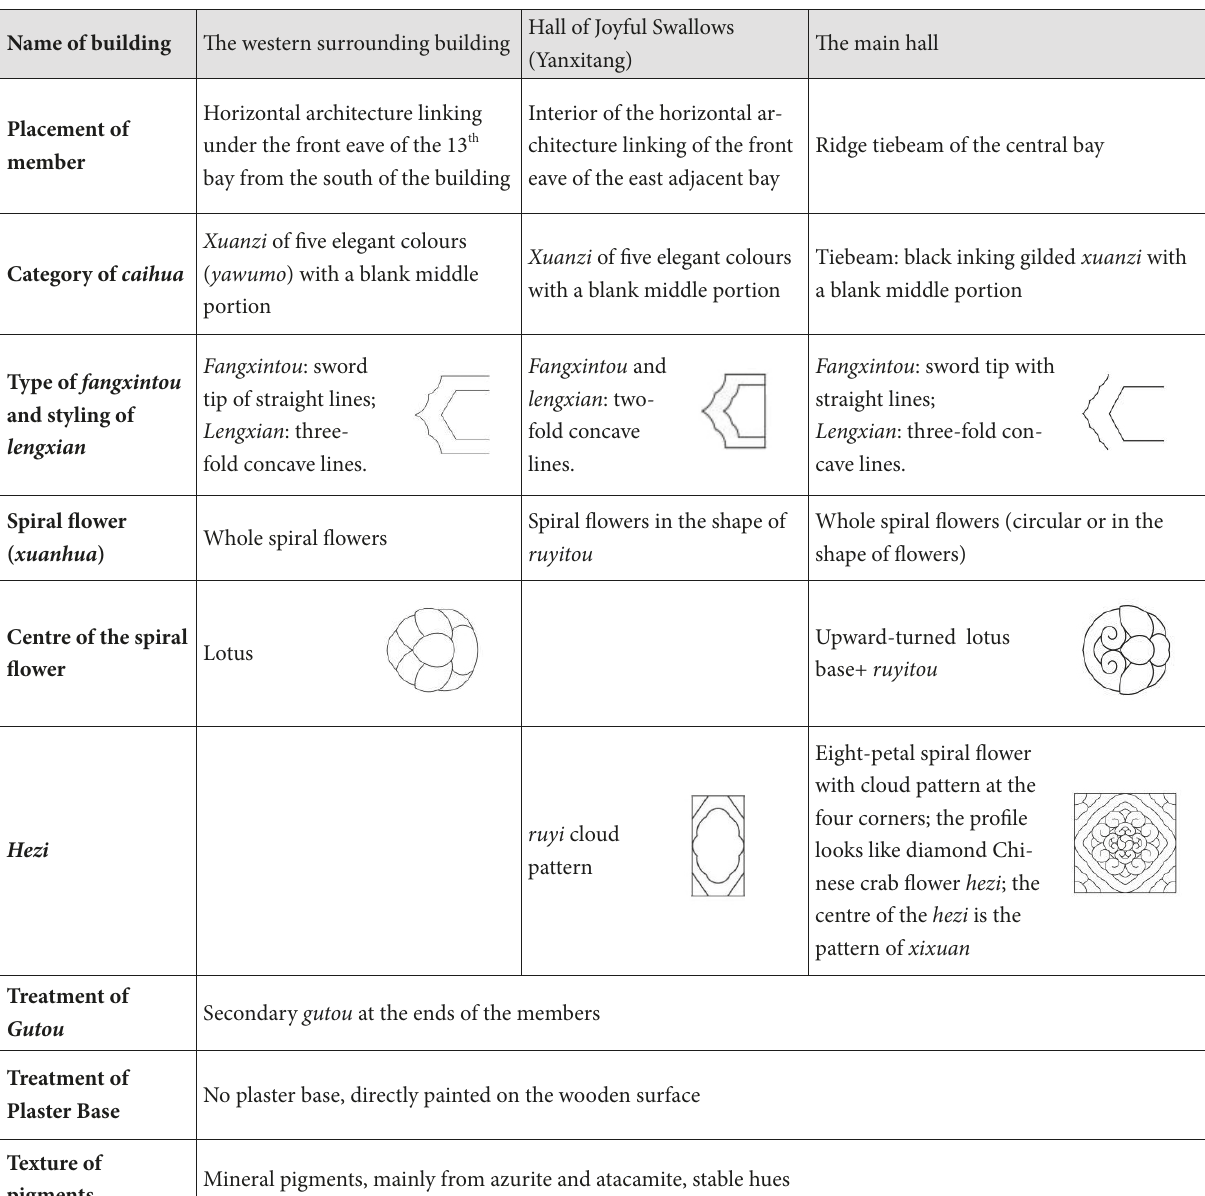
Table 1 Cross-reference of the patterns used in the decorative polychrome painting of the ridge tiebeam of the main hall, Hall of Joyful Swallows and the western surrounding building (Source: Hong